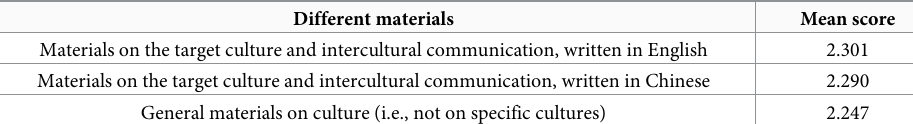
Table 10. The helpfulness of different cultural teaching